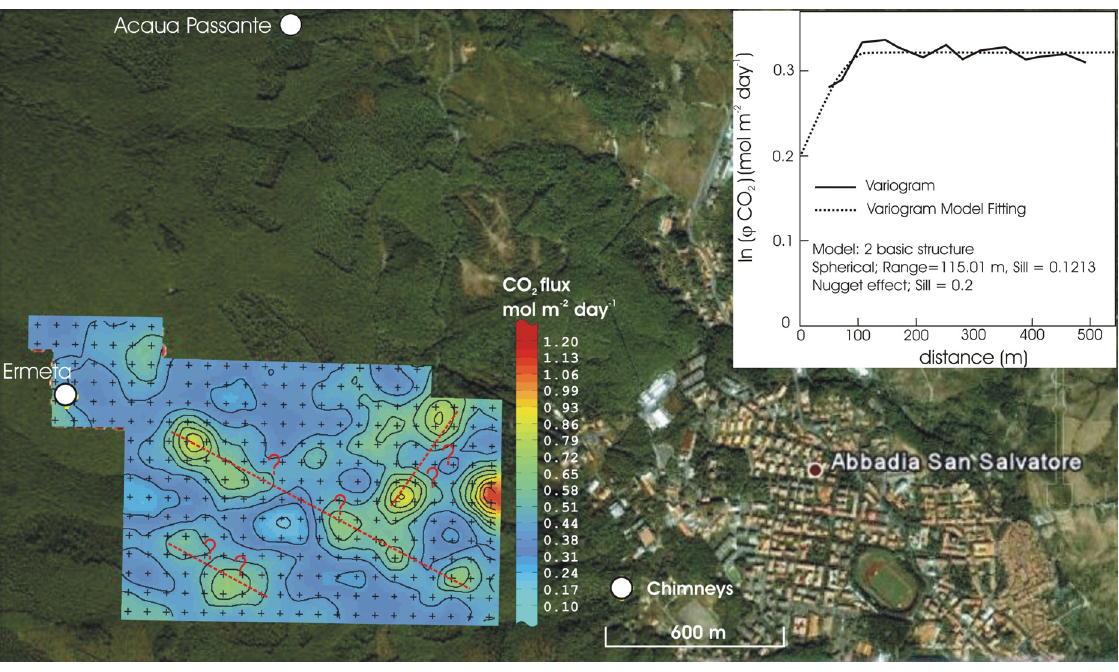
(in mol m -2 day -1 ) for the area close to the Ermeta well. Red dashed lines refer to preferential alignments Figure 6. Map of soil diffuse ϕ CO 2 (faults or fractures) where highest CO flux values were measured. 2